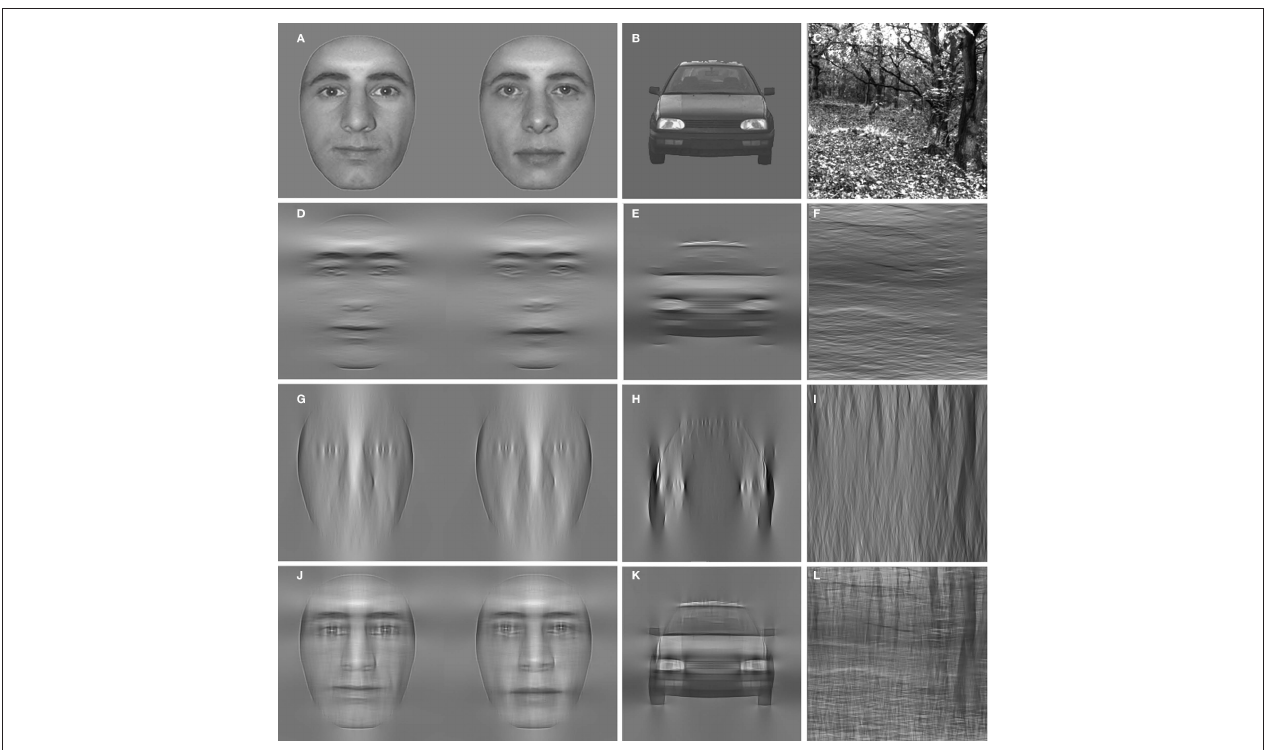
Figure 1 | Face, object and scene pictures (A–C) were filtered to preserve either horizontal (D–F), vertical (g–i) or both horizontal and vertical orientations